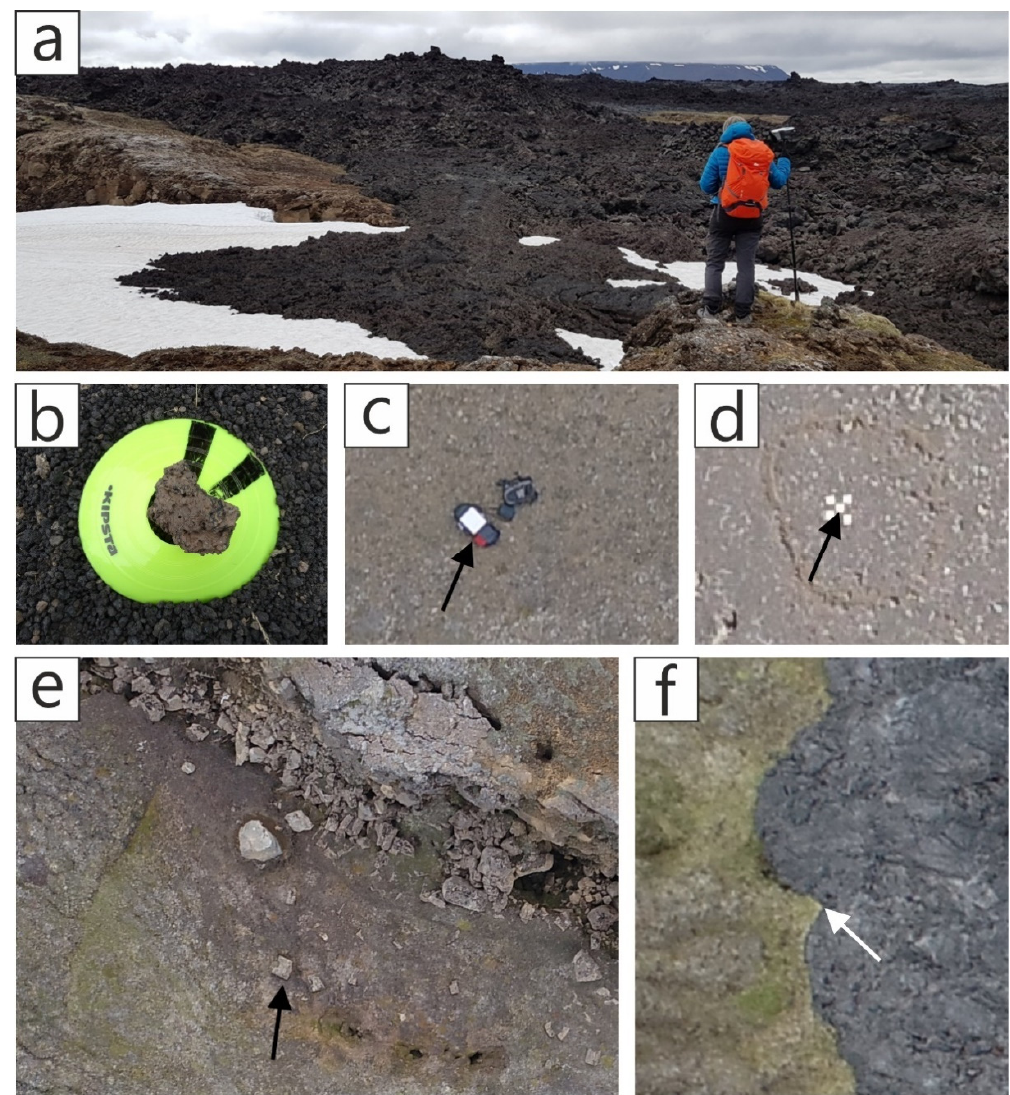
Figure 3. Examples of artificial and natural targets used in the present work to collect ground control points (GCPs). ( a ) Operator collecting a GCP in the field using RTK GPS receiver. ( b ) Artificial target as large as 20 cm, we collected the uppermost black band. ( c ) Corner of drone gray box (that is as large as 35 cm). ( d ) Five slices of bread adjusted to form a X, we collected the corner of the central one (as large as 10 cm). ( e ) Lower right corner of massive rocks (the rock is as large as 1 m). ( f ) Lava flow margin where it forms a 90° angle.